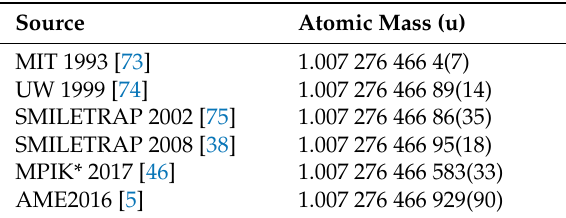
Table 1. Atomic mass values for the